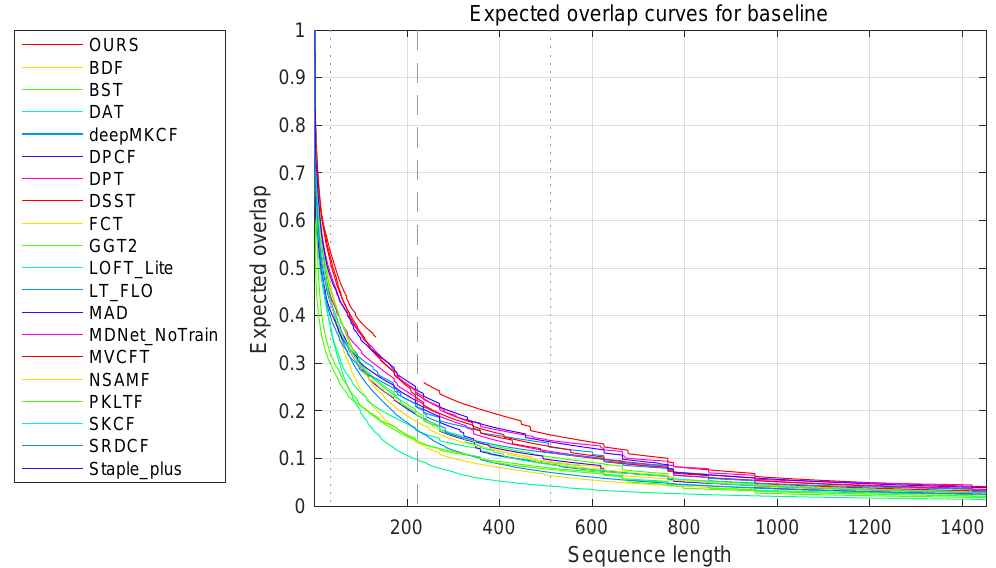
Figure 7. Expected overlap curves of the 20 compared trackers on